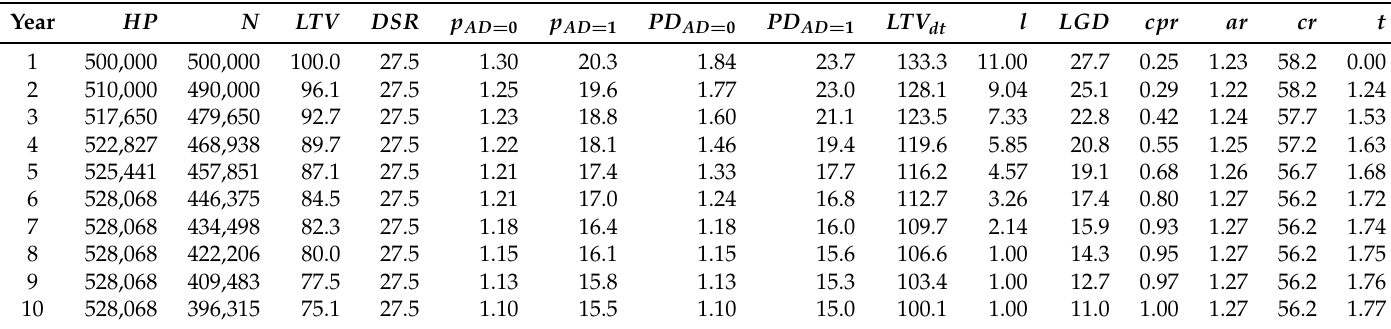
Table 5. Projection of house price ( HP ), loan balance ( N ), LTV (in %), DSC (in %), PIT PD conditional on AD = 0 (in %) by (33), PIT PD conditional on AD = 1 (in %) by (33), LTV dt in the 25% house price decline scenario, TTC PD conditional on AD = 0 (in %), TTC PD conditional on AD = 1 (in %), PIT loss rate l (in %), downturn LGD (in %) by (34), prepayment probability (in %) by (35), arrears rate (in %) by (36), cure rate (in %) by (37), Stage 2 probability (in %).